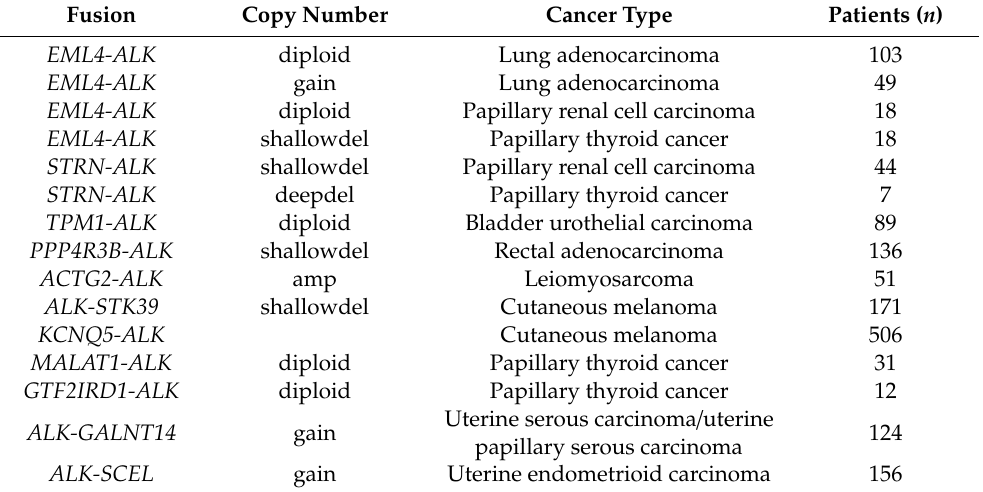
Table 1. Genetic fusion of ALK with other mRNAs involved in di ff erent types of cancers, based on data retrieved from the TCGA PanCancer Atlas using cBioPortal (10,953 patients / 10,967